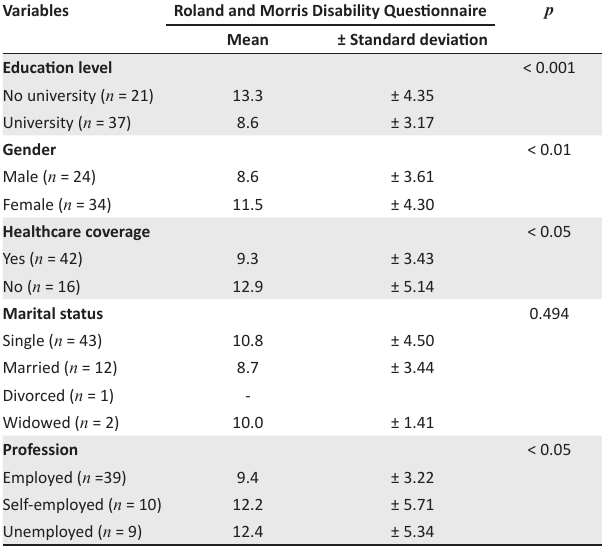
TABLE 2: Chronic low back pain-related activity limitations distribution according to sociodemographic variables ( n = 58). Variables